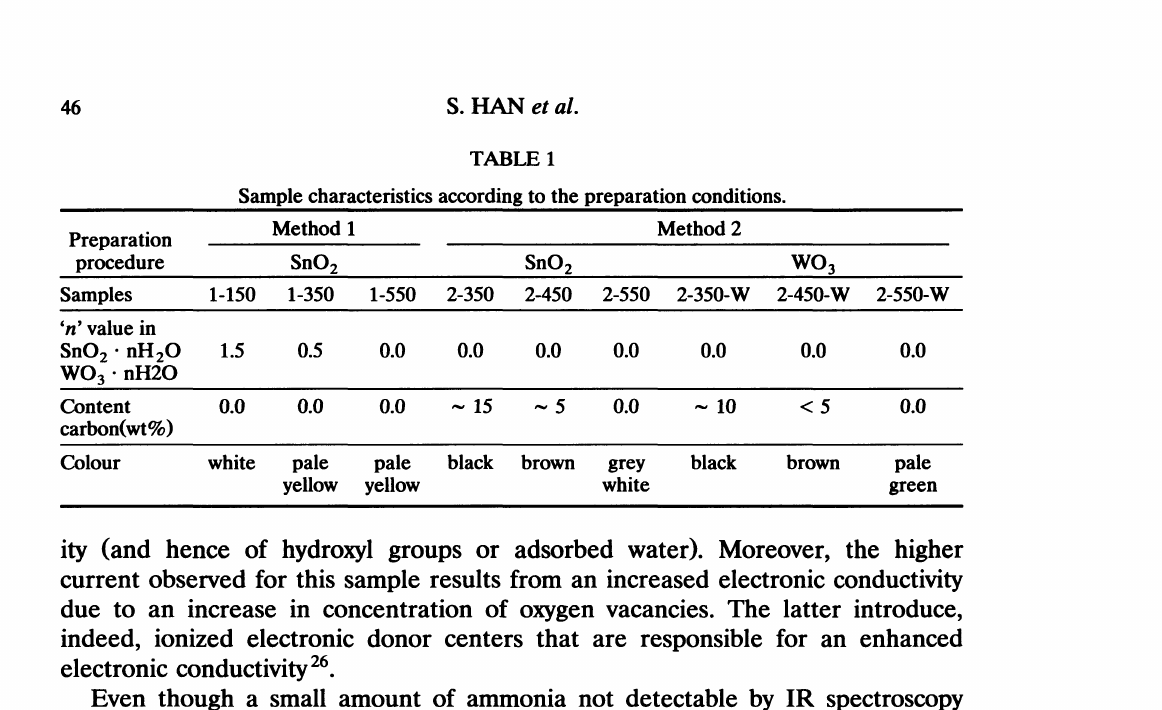
Sample characteristics according to the preparation